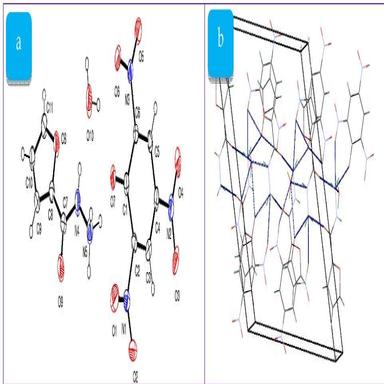
ORTEP of FHM b) Crystal packing in the unit cell